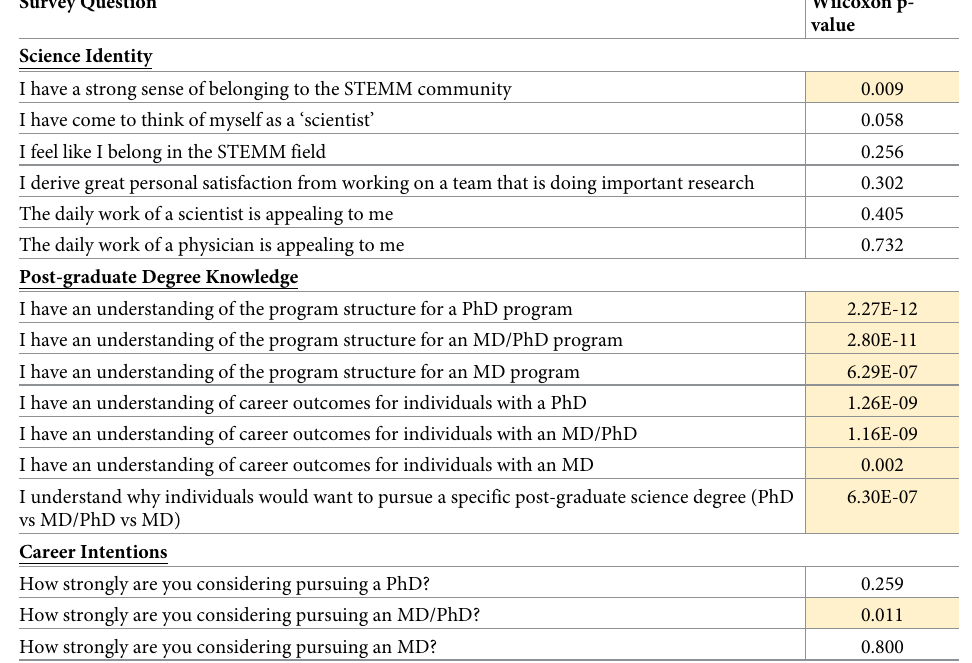
Table 1. Overall, the program increased a sense of belonging in the STEMM community, postgraduate degree knowledge, and interest in M.D./Ph.D. degree paths. Survey Question